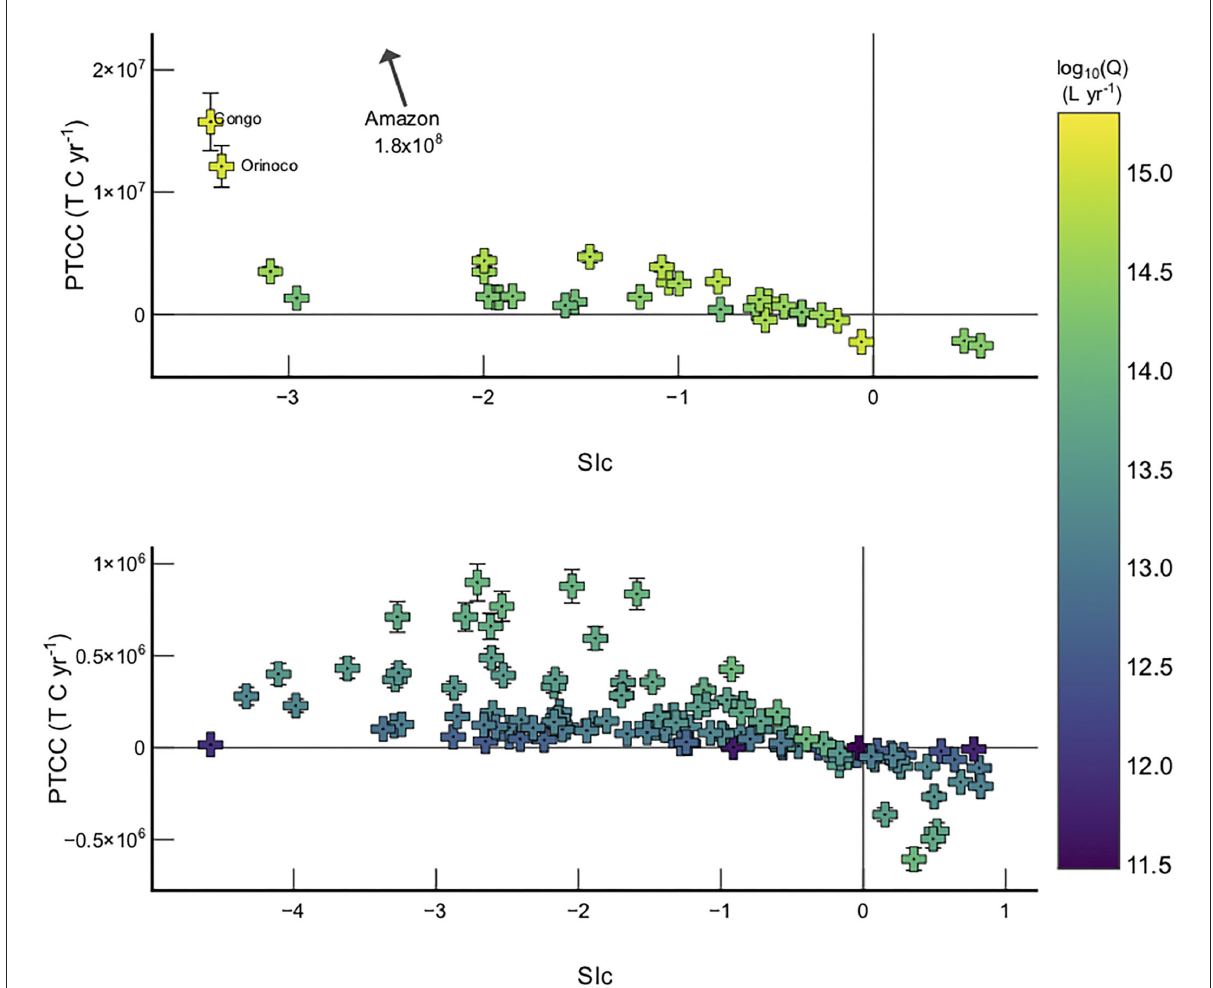
FIGURE6 Sic vs PTCC >1 × 10 14 L yr − 1 (top) and rivers with discharge <1 × 10 14 L yr − 1 (bottom). Error bars are not visible for data where the error is smaller than the data